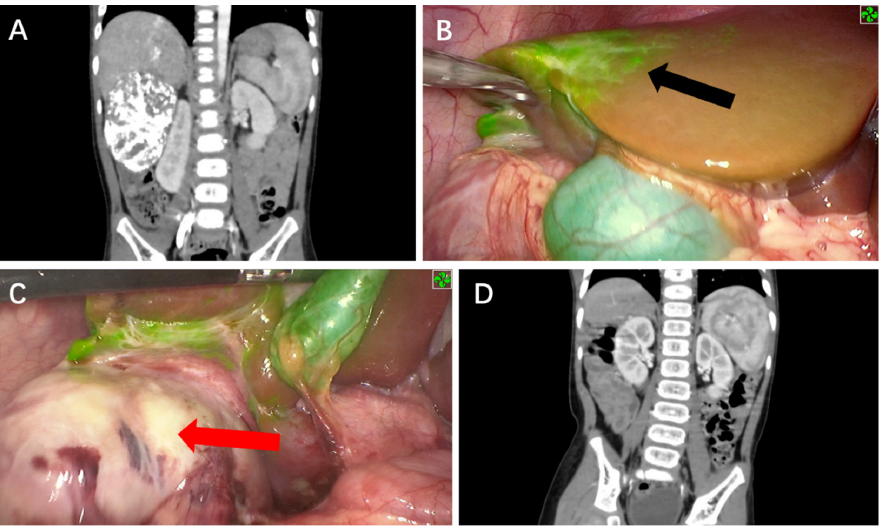
Figure 3. ICG fluorescence-guided laparoscopic hepatectomy of Segments 5, 6, and 7. ( A ) Preoperative CT image to assess tumor size and extent. ( B ) Irregular fluorescence was observed between the tumor and normal liver tissues in intraoperative fluorescence mode (black arrow). ( C ) No obvious fluorescence was seen in the tumor (red arrow). ( D ) No signs of tumor residues or recurrence were observed via CT 12 months after surgery.